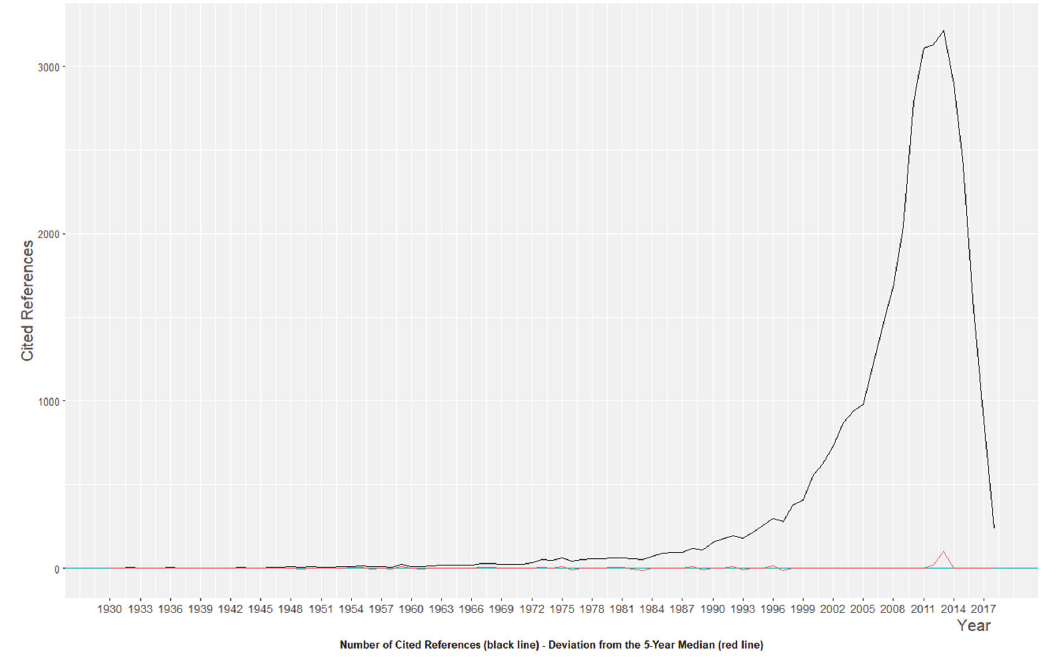
Fig. 8. Reference publication year